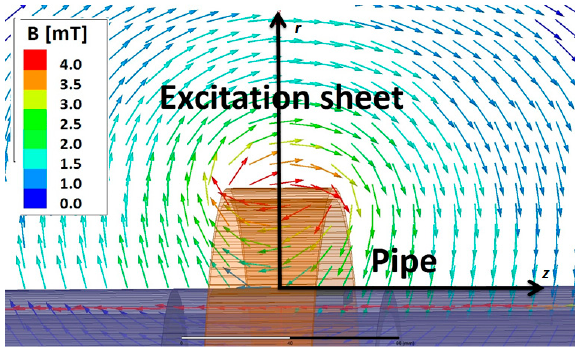
Figure 2. Magnetic field vector plot in r-z plane at 20 Hz excitation frequency.